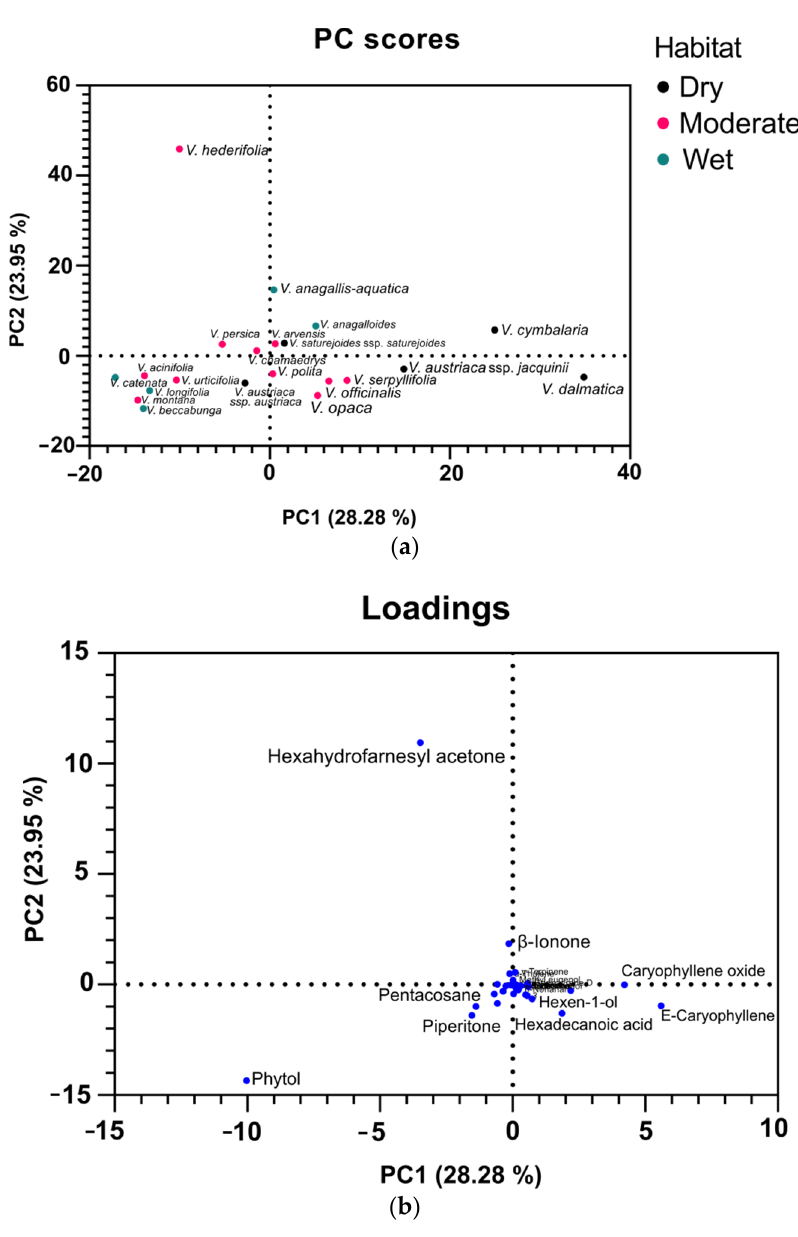
Figure 8. PCA analyses of volatile compounds of 21 Veronica species obtained by microwave extraction. The PCA score plot allocating different species to clusters ( a ); PCA loading plots of volatiles from the first and second principal components ( b ).